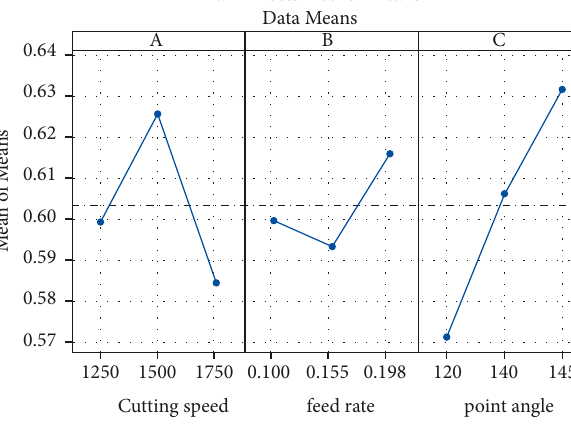
Figure 4: Main effects plot for means: cutting force.